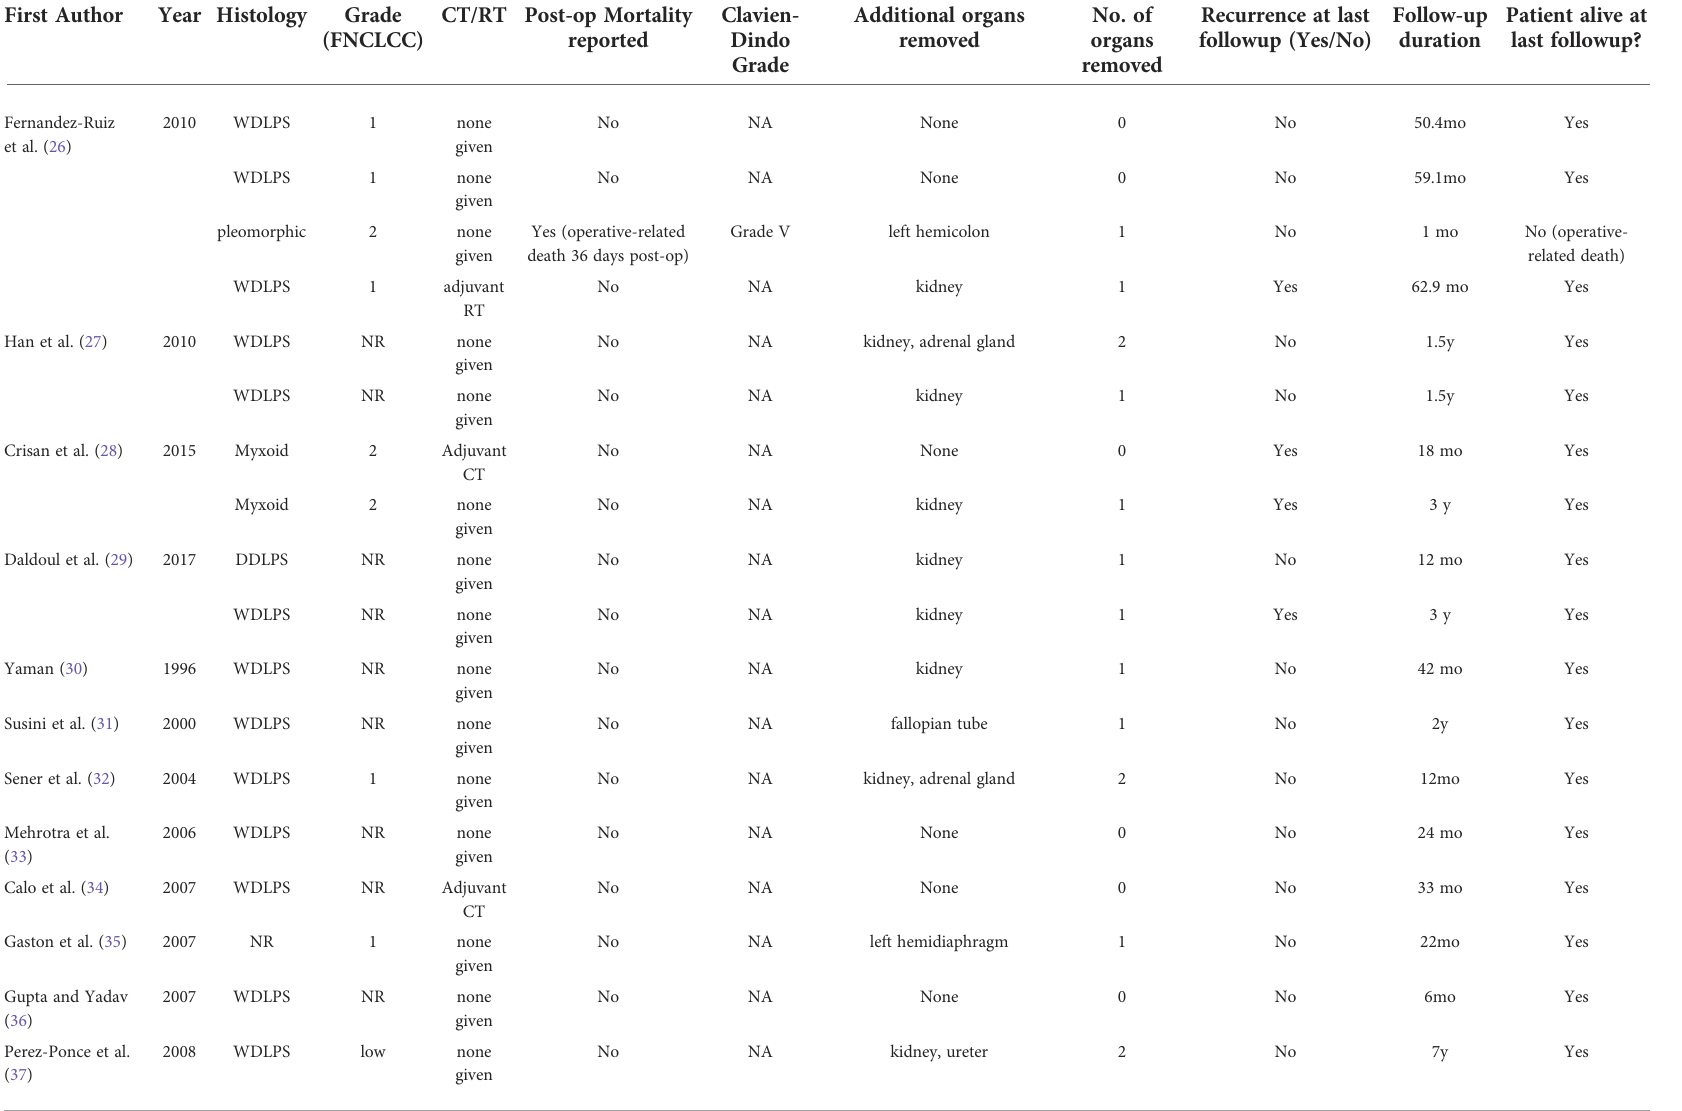
TABLE 3A Summary of 4 case series and 40 case reports which included patients receiving R0-margin